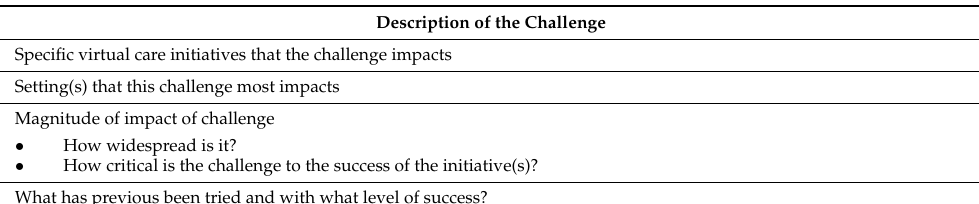
Table A3. Template for providing information for individual virtual care